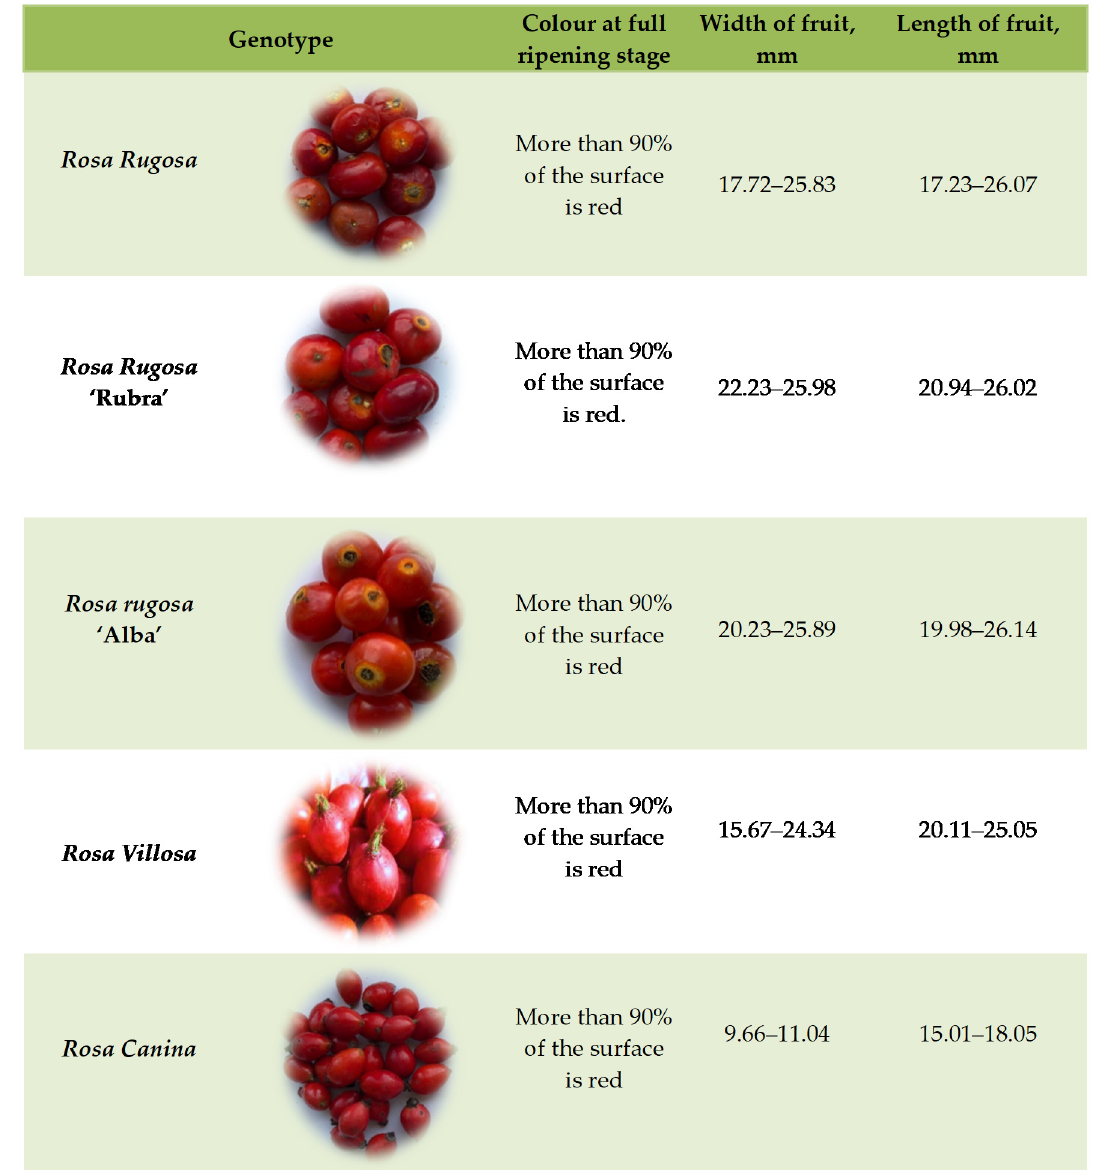
Figure 1. Fruits of different organic Rosa species.